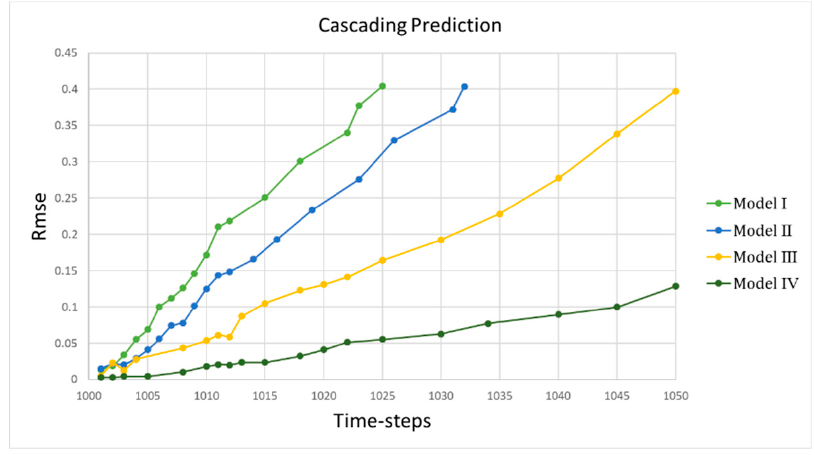
Figure 42. Comparison of the results